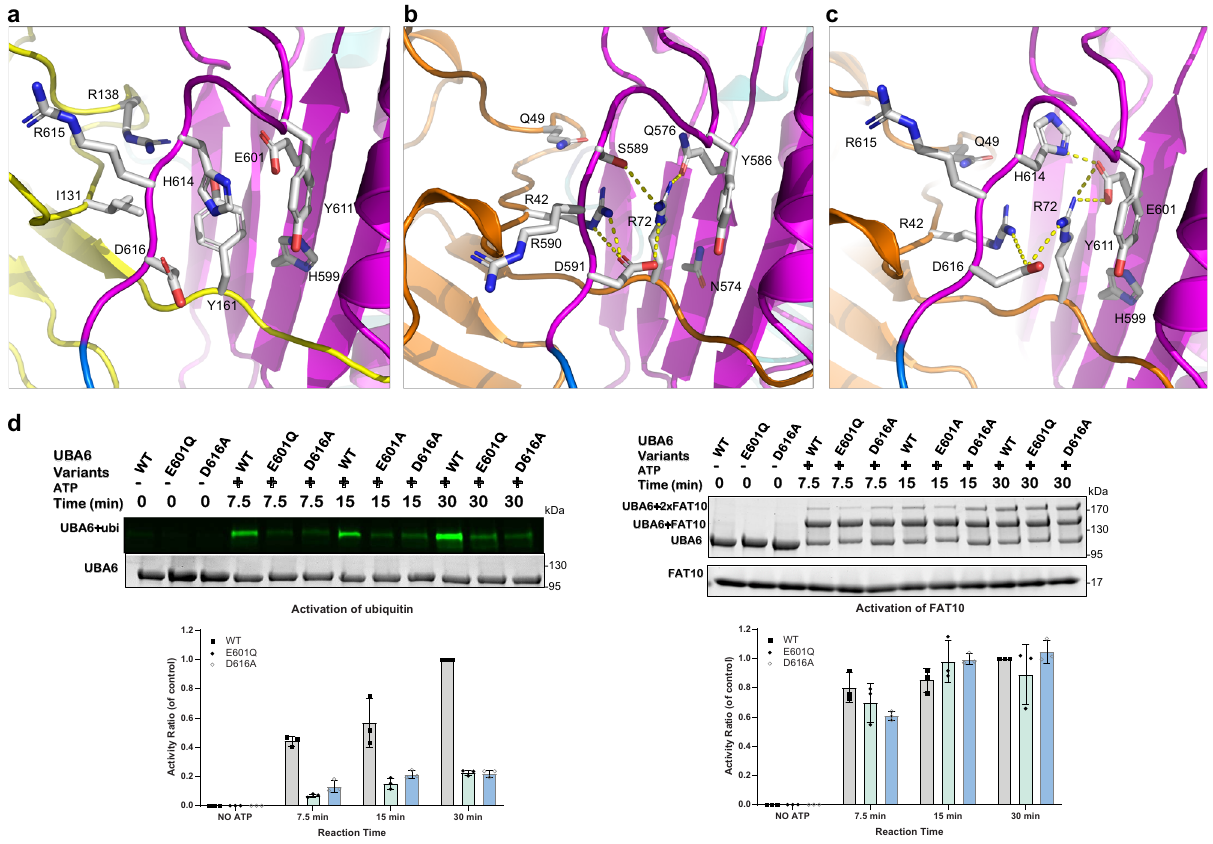
Fig.6|Molecularbasisofthedualspeci fi cityofUBA6andselectiveabrogation of ubiquitylation. a Recognition of the Y161 speci fi city determinant of FAT10 (yellow) by UBA6 in a predominantlyhydrophobic pocket. b Interactions between R72 of ubiquitin (orange) and Uba1 (PDB entry 6zqh) with polar interactions indicated as dashed yellow lines. c Model of the UBA6-ubiquitin complex.